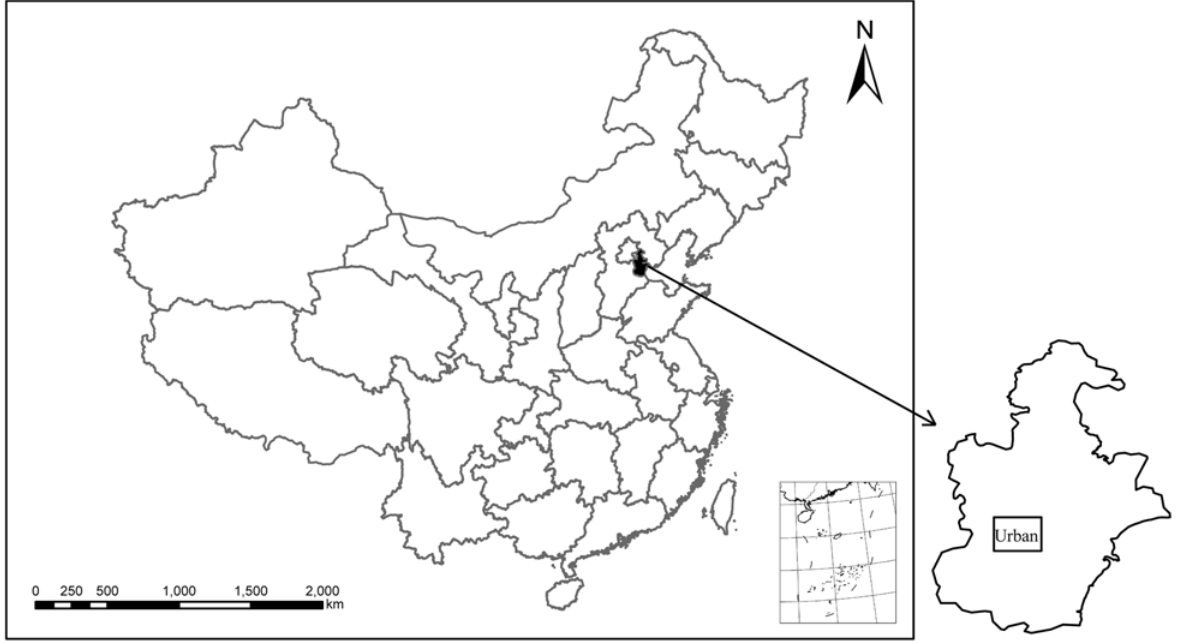
Fig 1. The location of study area in China and the site of selected buildings in Tianjin